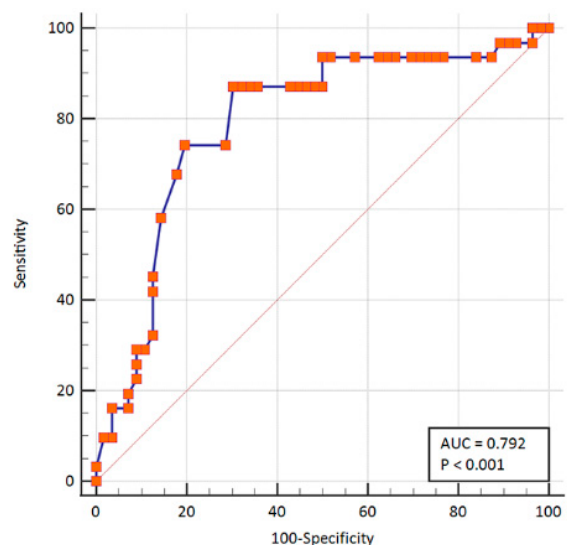
Figure 3. The diagnostic value of wall shear stress (WSS) in distinguishing between the asymptomatic and symptomatic carotid atherosclerotic stenosis.